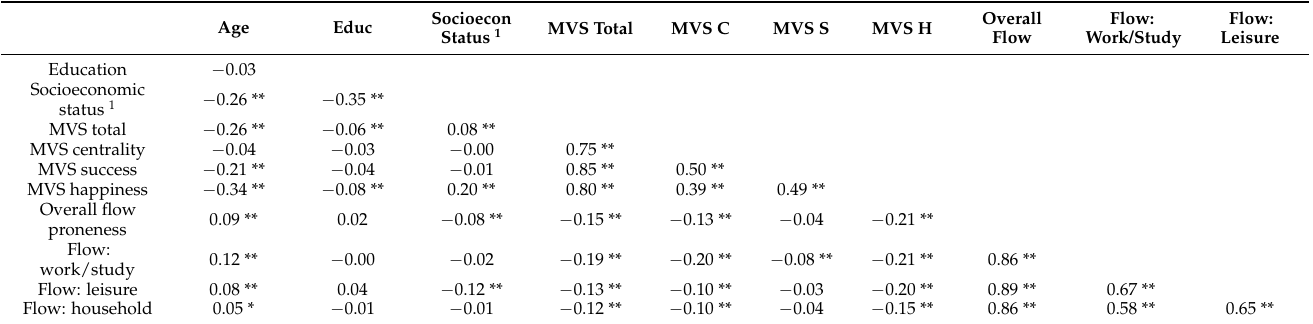
Table 6. Correlations between all variables in Study 3.